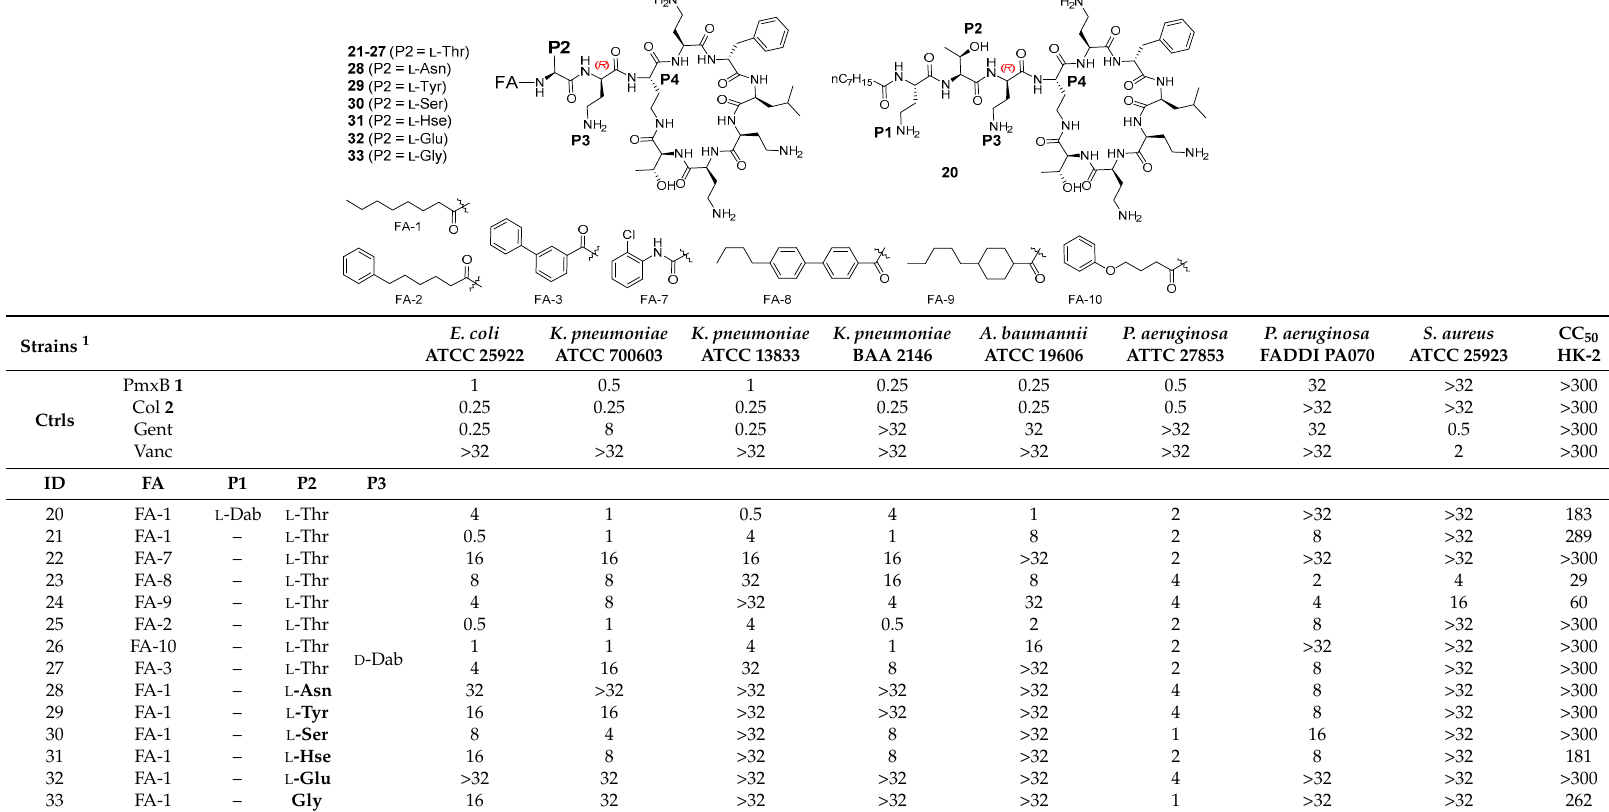
Table 2. Summary of antimicrobial activity (MIC, mg/L) and cytotoxicity (CC 50 , µM) against HK-2 cells for a series of polymyxin-B nonapeptide (PMBN) derivatives acylated with different fatty acids and varying the P2 residue.